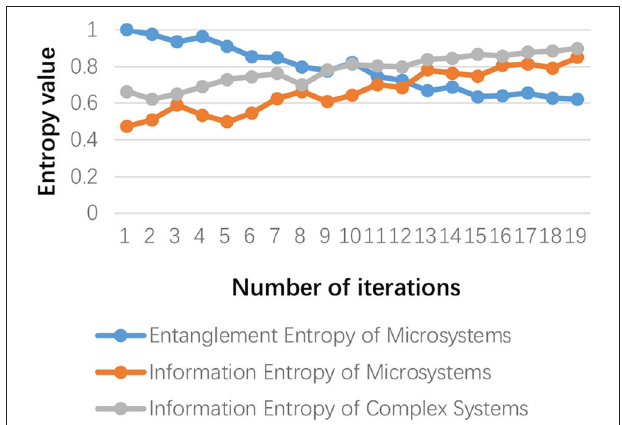
FIGURE 12 | Entanglement entropy, quantum system information entropy, and complex system information entropy.